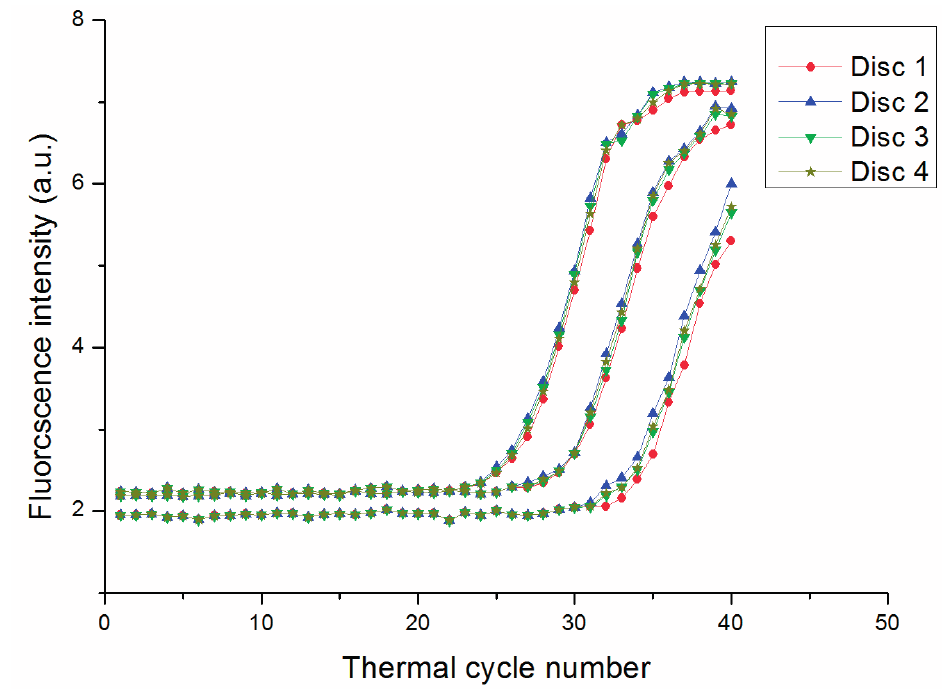
Figure 9. The fl uorescence intensity curve for 10 3 , 10 4 and 10 5 copies/mL DNA with four discs in the same turntable